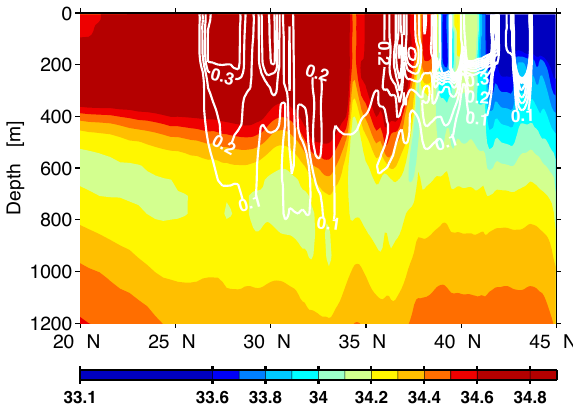
Fig. 13. Simulated (nominal year 1996 simulation) salinity (in color) and 137 Cs activities (white contours) in units mBql − 1 along 150 ◦ E on 1 April, one year after the 137 Cs